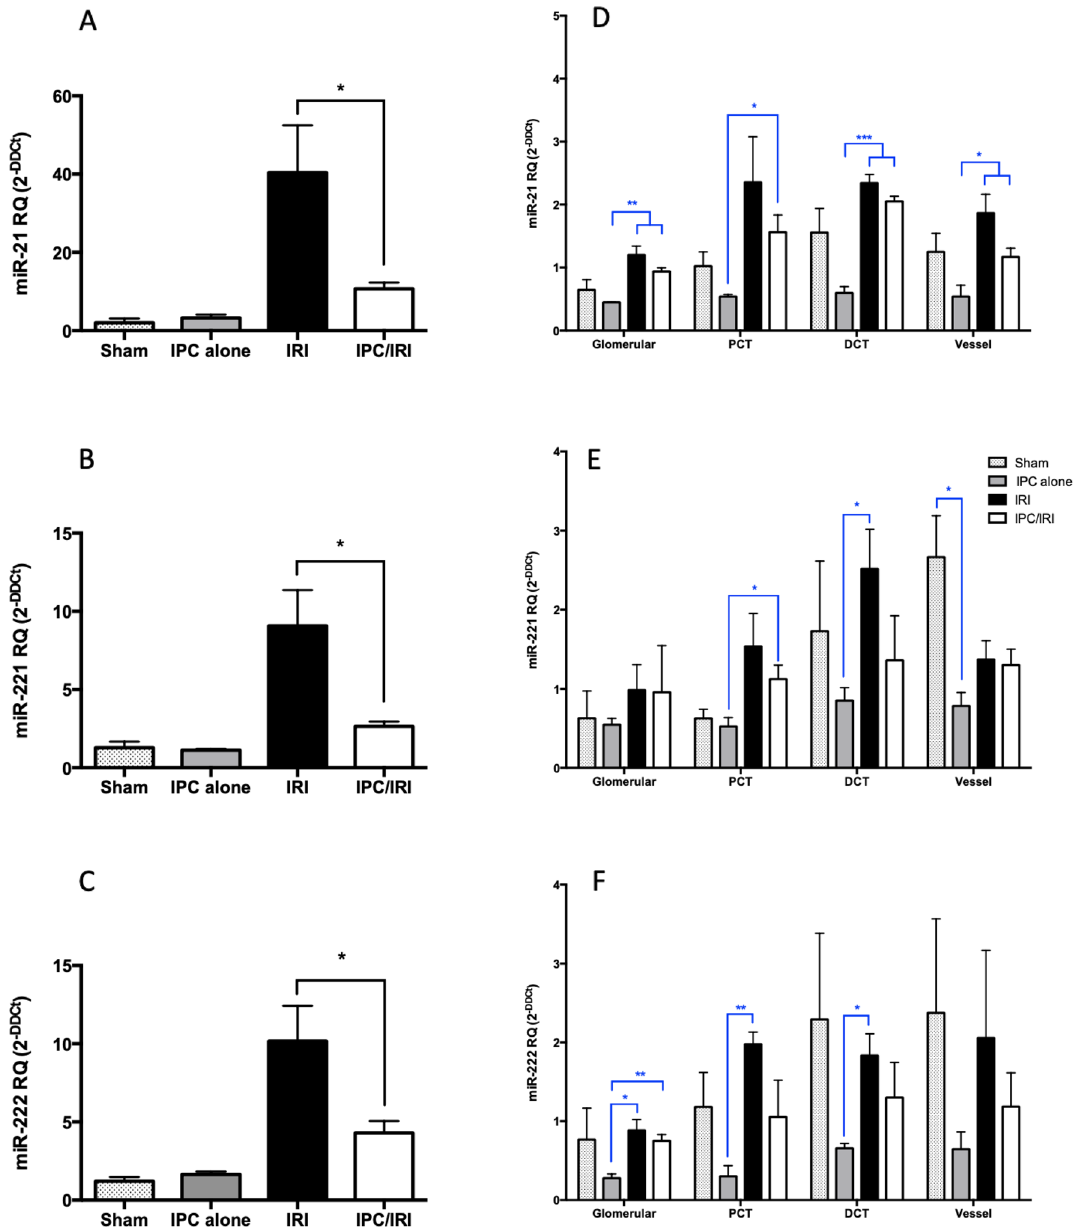
Figure 7. Localisation of miR-21-5p, miR-221-3p, and miR-222-3p by Laser Capture Microdissection analysis. (A–C) RT-qPCR for selected microRNAs in sham (n = 8), 45 min bilateral IRI (n = 9), localised pulsatile IPC prior to IRI (n = 8), and localised pulsatile IPC alone (n = 8), rats at 48 h after reperfusion (A) miR-21-5p, (B) miR-221-3p, (C) miR-222-3p (D–F) MicroRNA expression in nephron sub-compartments. Laser Capture Microdissection (LCM) of: Glomerulus, G; Proximal Convoluted Tubule, PCT; Distal Convoluted Tubule, DCT; and Vessel, V using cortical sections from Sham, IRI, IPC prior to IRI, and IPC alone (n = 3 animals per group). (D) miR-21-5p, (E) miR-221-3p, (F) miR-222-3p. Expression is normalised to miR-16-5p and plotted as mean ± SEM. Statistical significance: *p < 0.05, **p < 0.01, ***p < 0.001. Statistically significant differences between groups have been